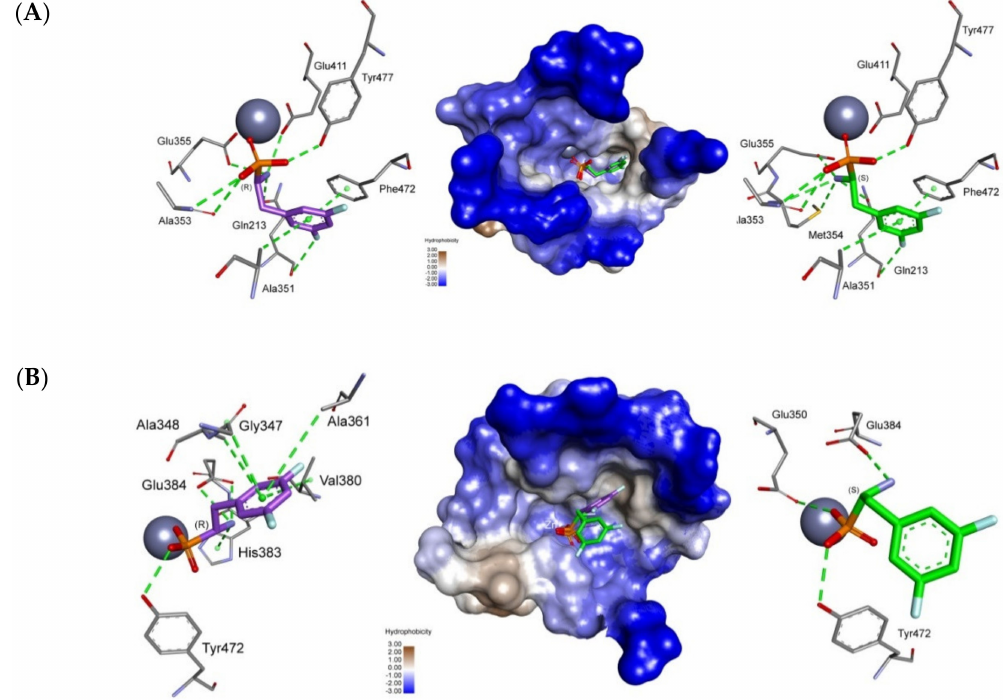
Figure 2. Modes of binding of both enantiomers of 1-amino-2-(3,5-difluorophenyl)ethylphosphonic acid (compound 1i ) to hAPN ( A ) and pAPN ( B ). Right hand side—R-isomer; left hand side—S-isomer. Coloration of the oxygen, amino and fluorine atoms is identical to that in Figure